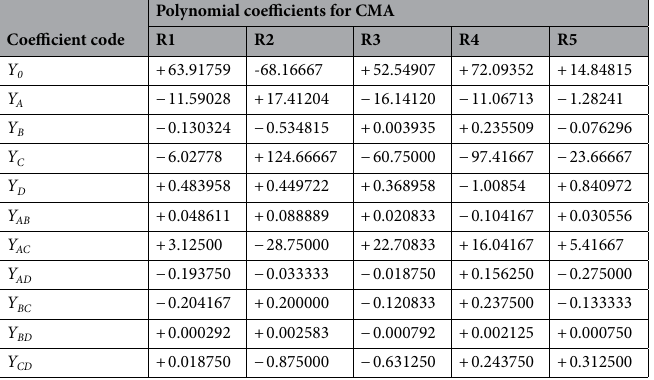
Table 3. Two-factor interaction equation for CMAs a . a R1: Rs between Imp-E & A; R2: Rs between Imp-D & MPM; R3: Rs between MPM & Imp-F; R4: Rs between Imp-F & B; R5: Rs between Imp-B &